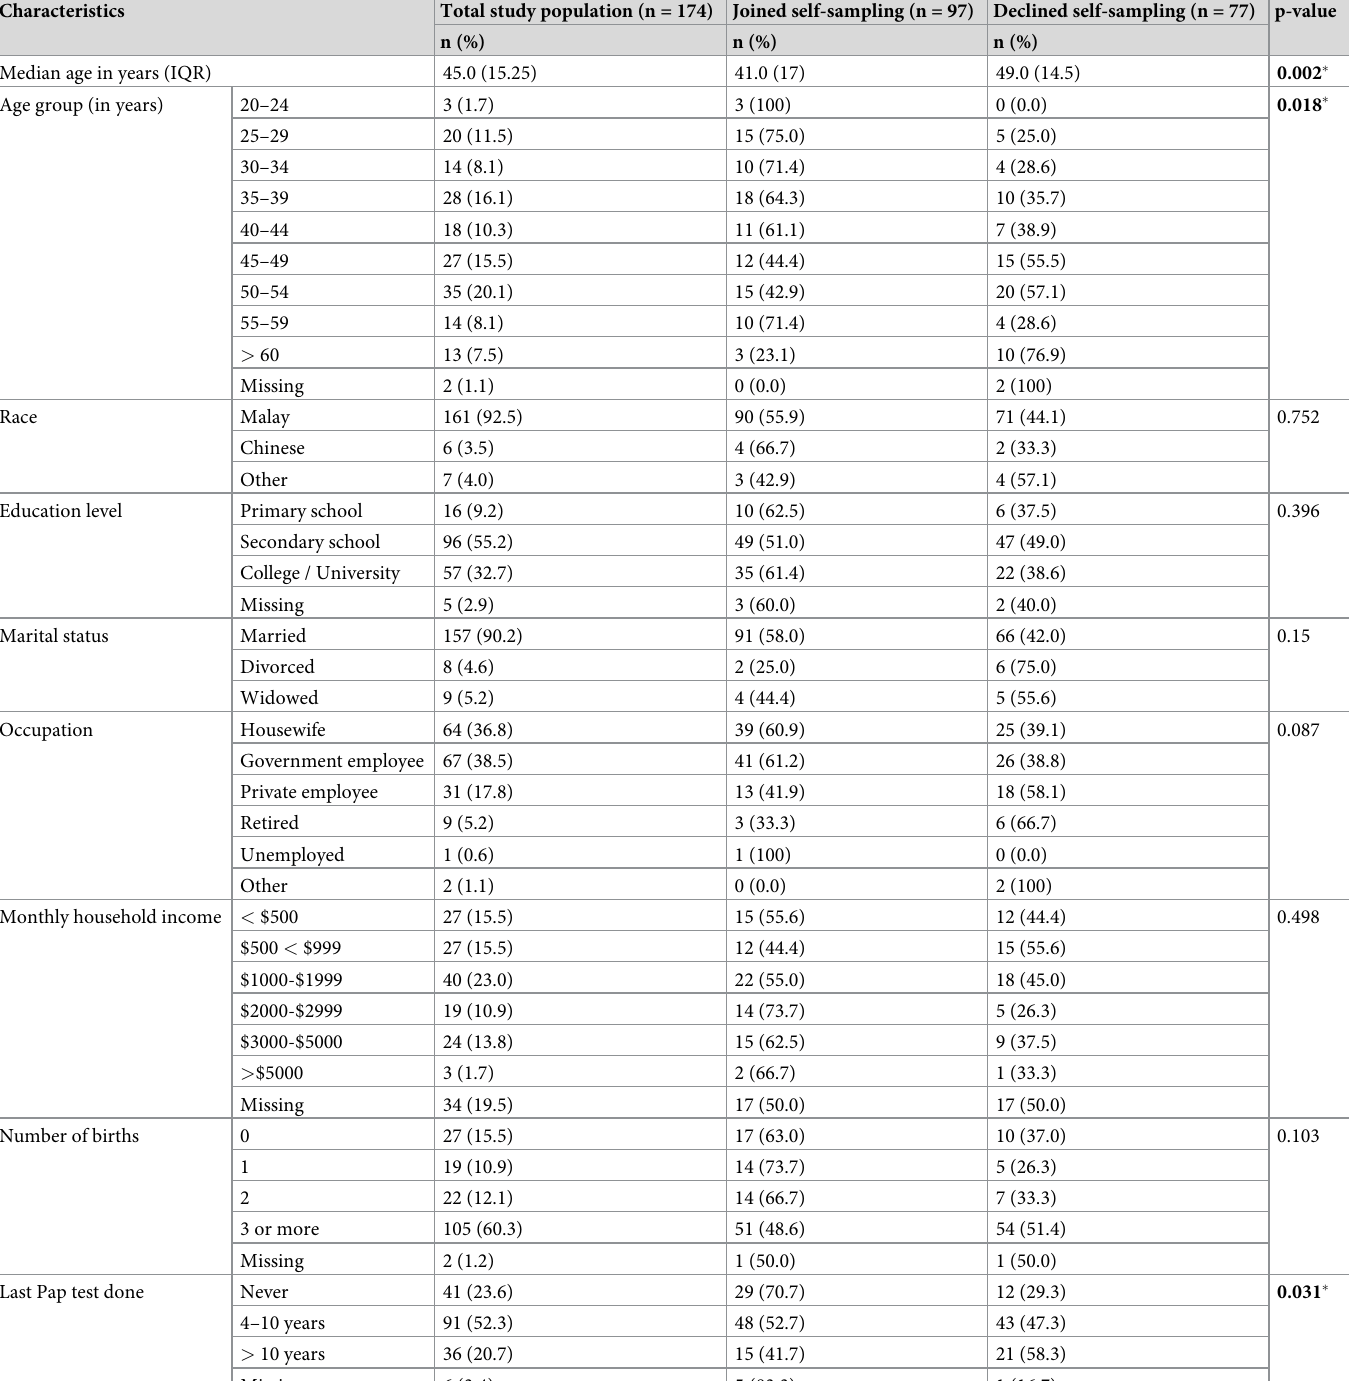
Table 1. Sociodemographic characteristics of the study population, including comparison between groups that agreed and declined to join HPV self-sampling.